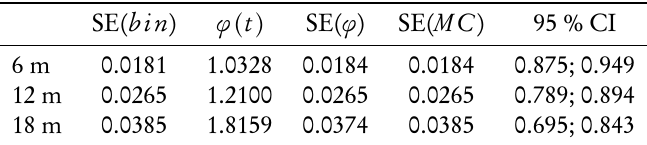
Standard error for the survival probabilities reported by Rajkumar et al. (2010) under the assumption of no censoring (SE(bin)), the variance inflation factor ( ϕ ( t ) ), the expected variance under the censoring assumption SE( ϕ )and mean SEs for 10 4 Monte Carlo simulations and the estimated 95 % confidence